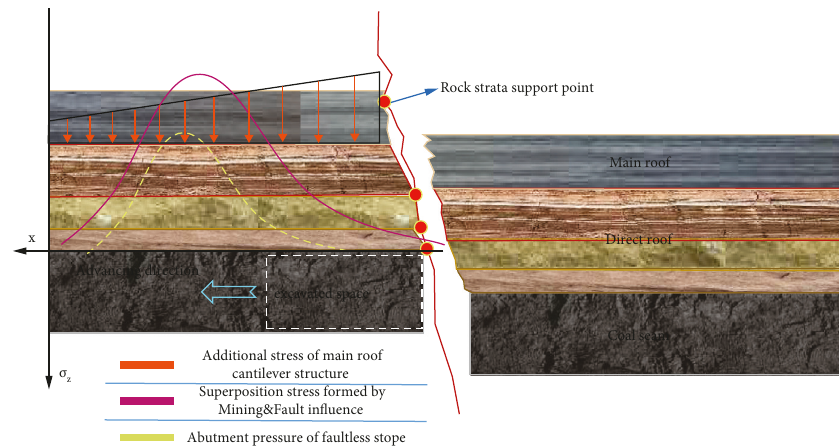
Figure 2: Suspension curve of fault stress and mining